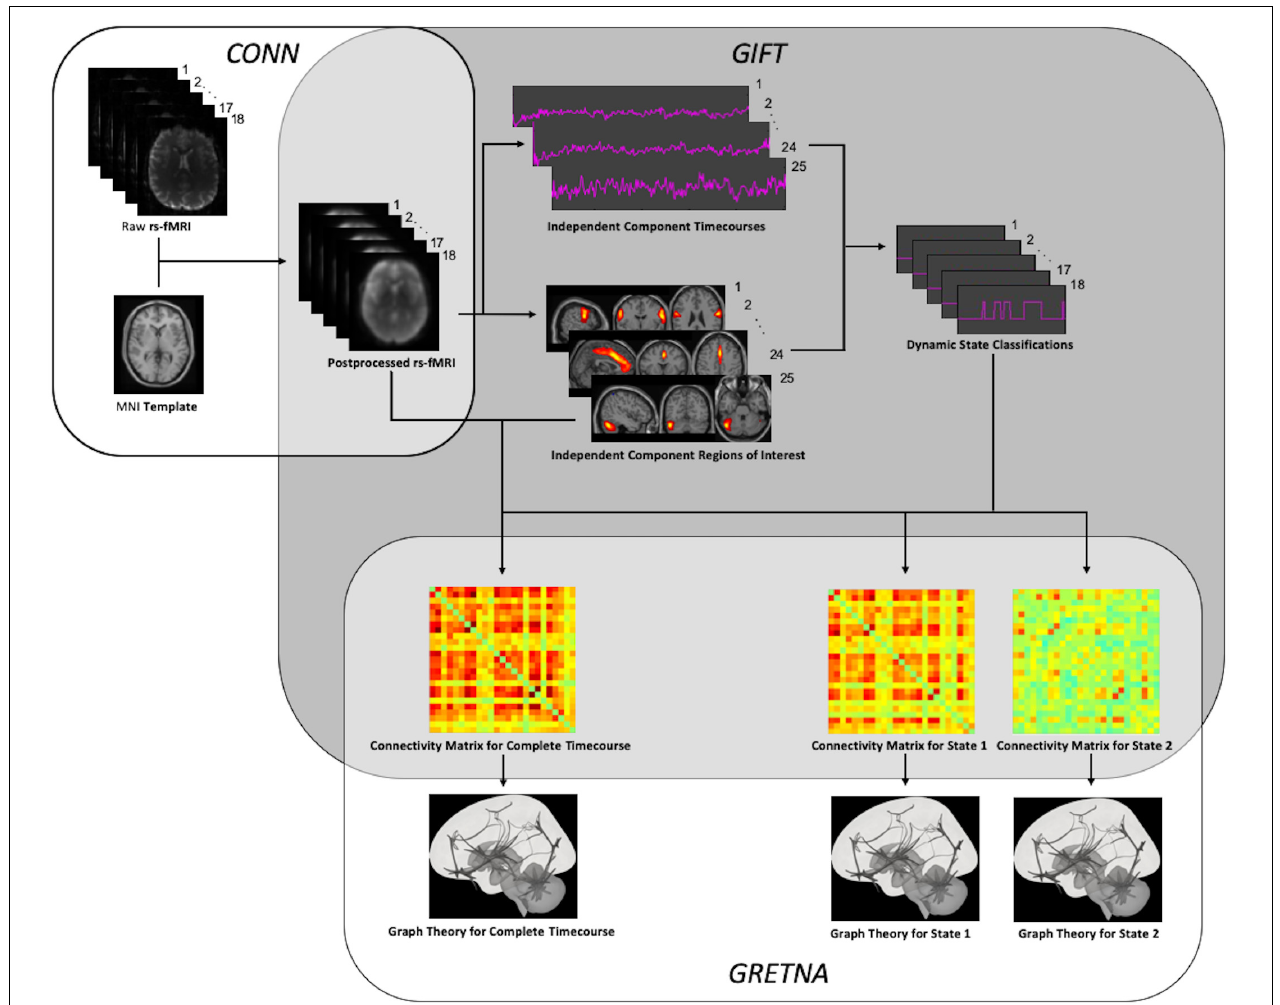
FIGURE 1 | Processing Workflow. After preprocessing using SPM and the CONN toolbox, independent components were extracted to allow for both static and dynamic ICA using the GIFT toolbox. After thresholding and binarization of the resulting functional connectivity matrices, graph theory was performed using the GRETNA